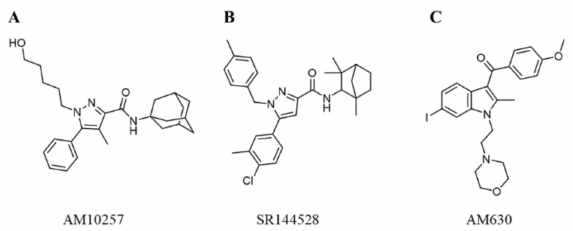
Figure 1. Representative chemical structures of known CB2 receptor antagonists: ( A ) AM10257, ( B ) SR144528, and ( C )